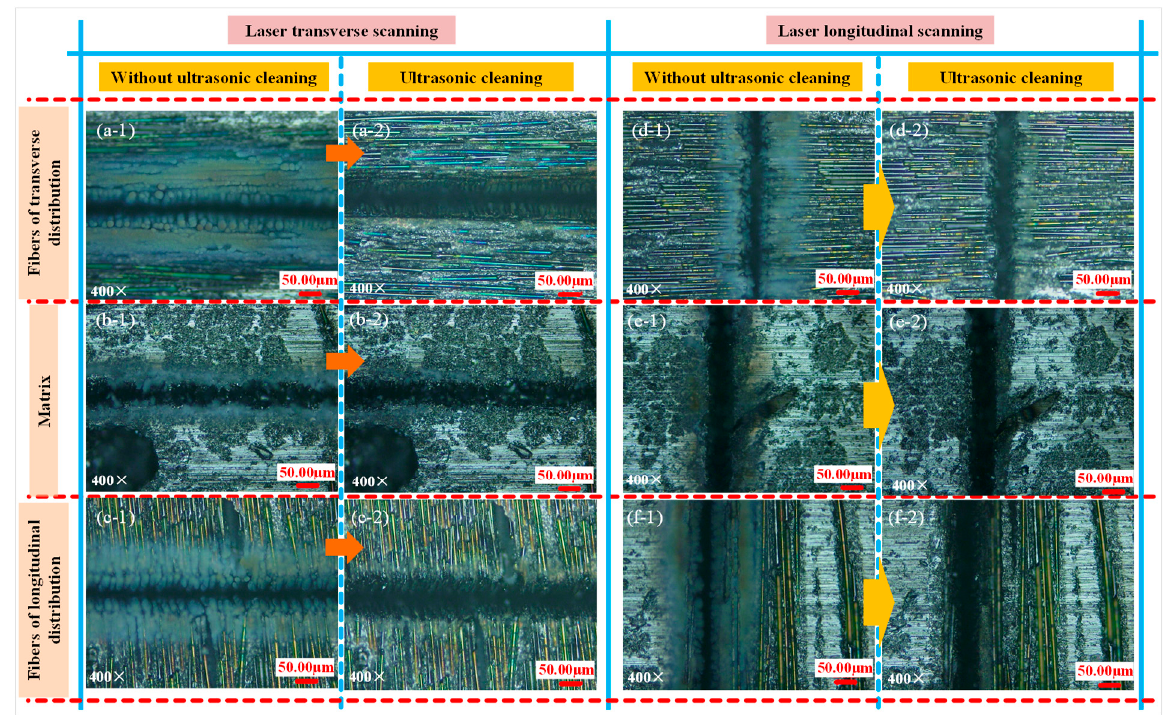
Figure 4. The grooved morphologies of different regions in experiment 1 ( a-1 – f-2 ).